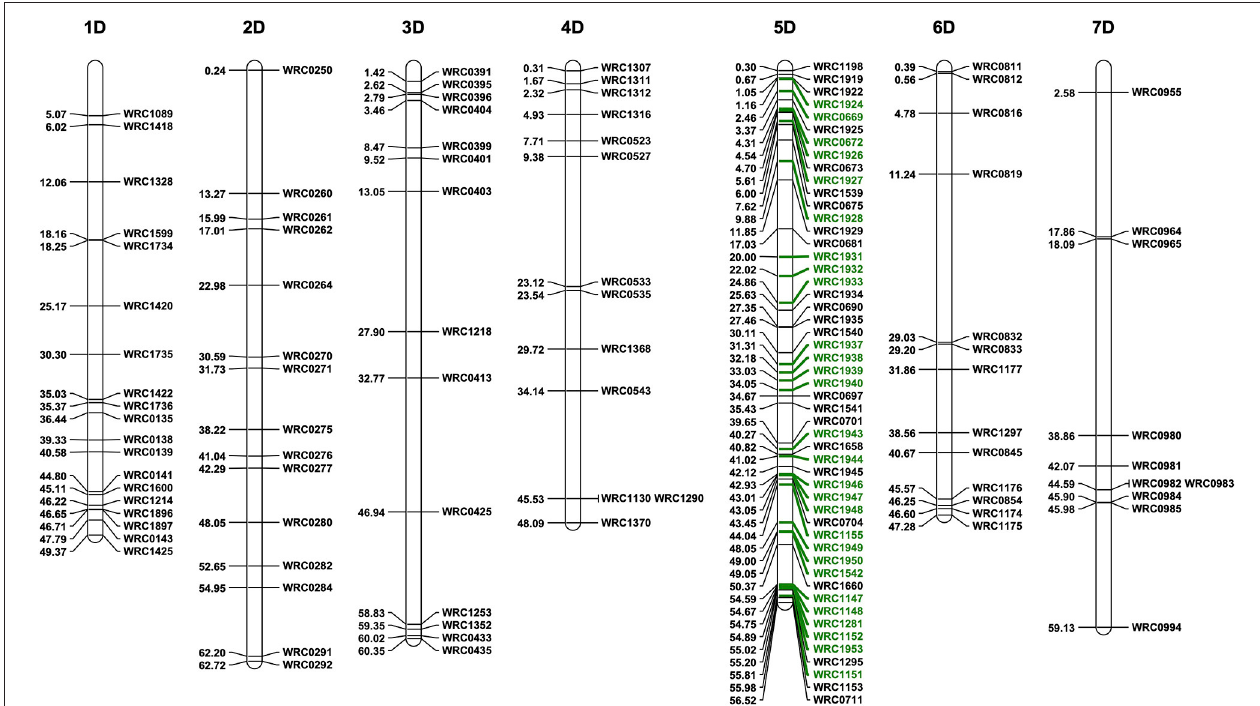
FIGURE 3 | Physical position of the D-genome-specific KASP markers on the seven D-genome linkage groups in bp 10 − 7 . Polymorphic KASP markers between Chinese Spring and Ae. tauschii for LG 5 are highlighted in